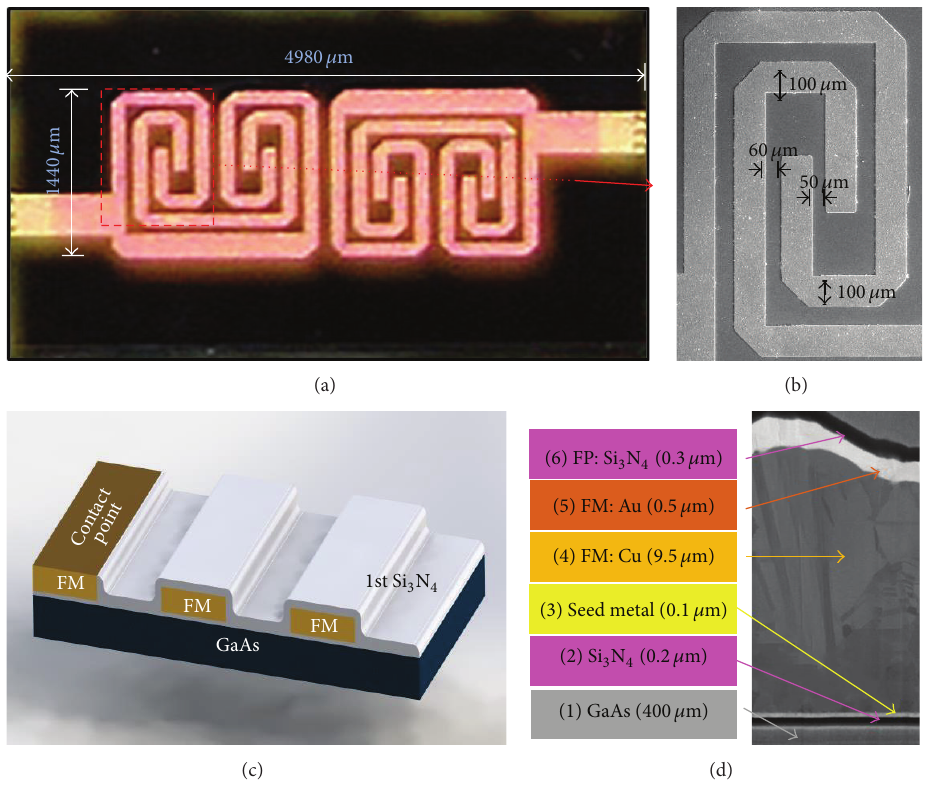
Figure 6: The enlarged image of the proposed BPF: (a) enlarged view of the layout. (b) SEM view of the emphasised region. (c) 3D cross- sectional view of the IPD process on GaAs. (d) FIB cross-sectional image of the BPF.